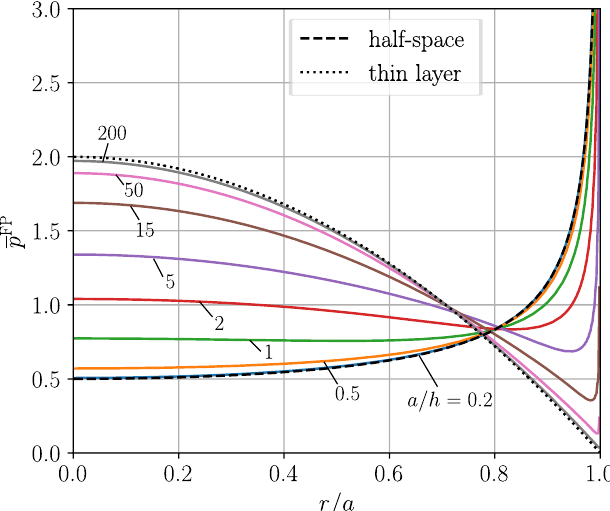
Figure 3. Normalized contact stiffness k N in terms of confinement ratio a / h . Symbols mark numerical data taken from Hayes et al. [11].